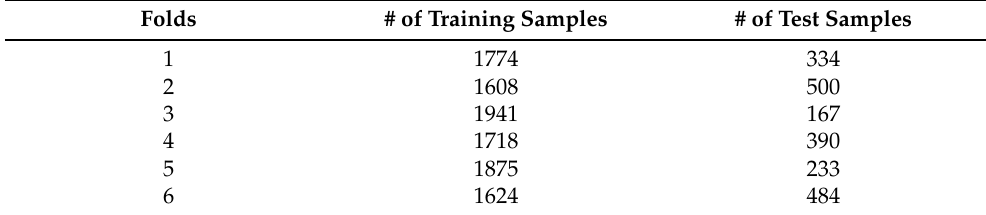
Table 3. User-tablet data recordings split into leave-one-user-out